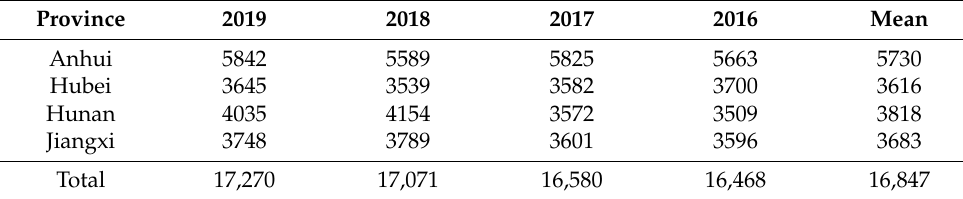
Table 3. Output of grain crops harvested in summer per hectare